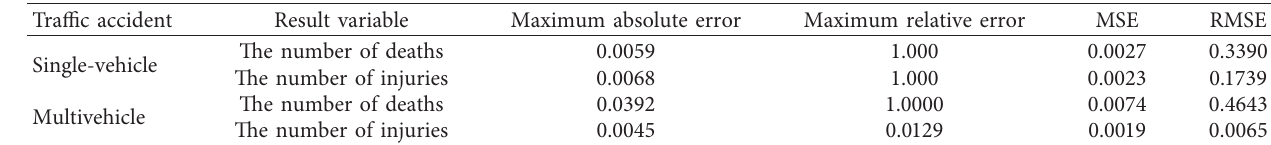
Table 12: Single-vehicle accident comparison result for the number of deaths.